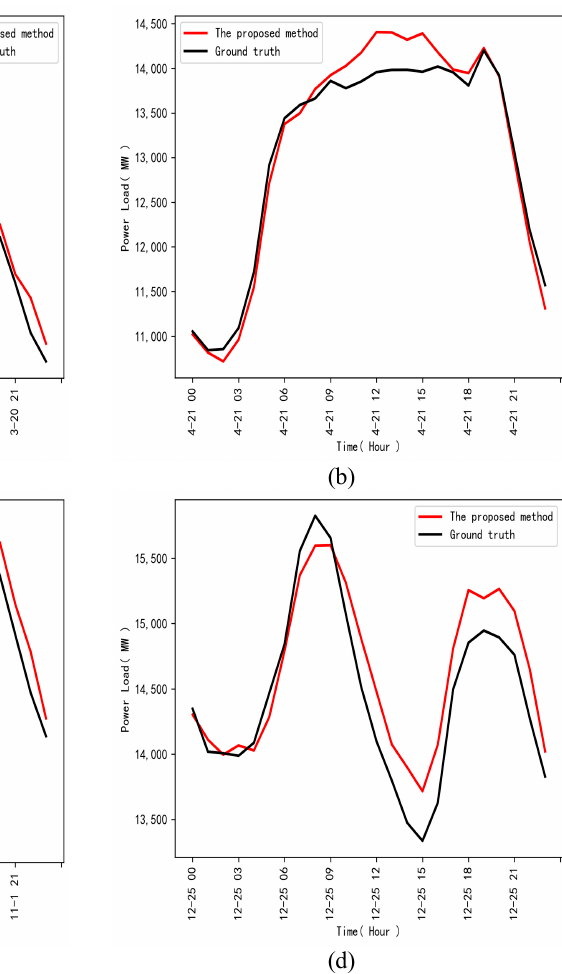
Figure 8. Prediction results for ( a ) 20 March 2019, ( b ) 21 April 2019, ( c ) 7 November 2019, and ( d ) 25 December 2019.